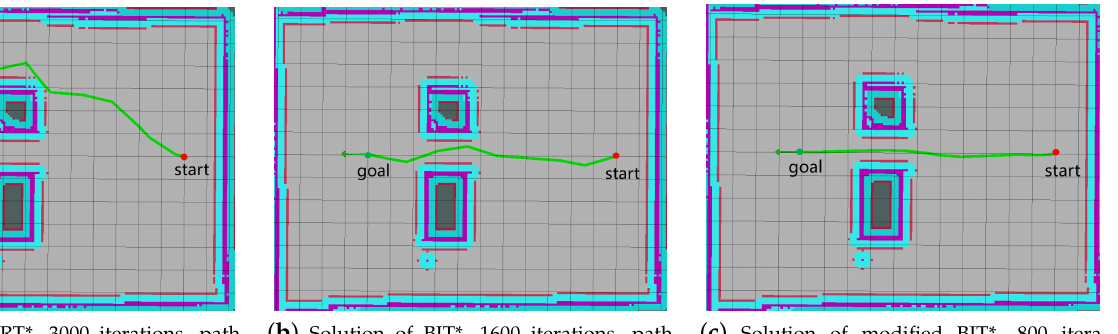
Figure 8. The performance of three planner in a scenario with few obstacles and a narrow